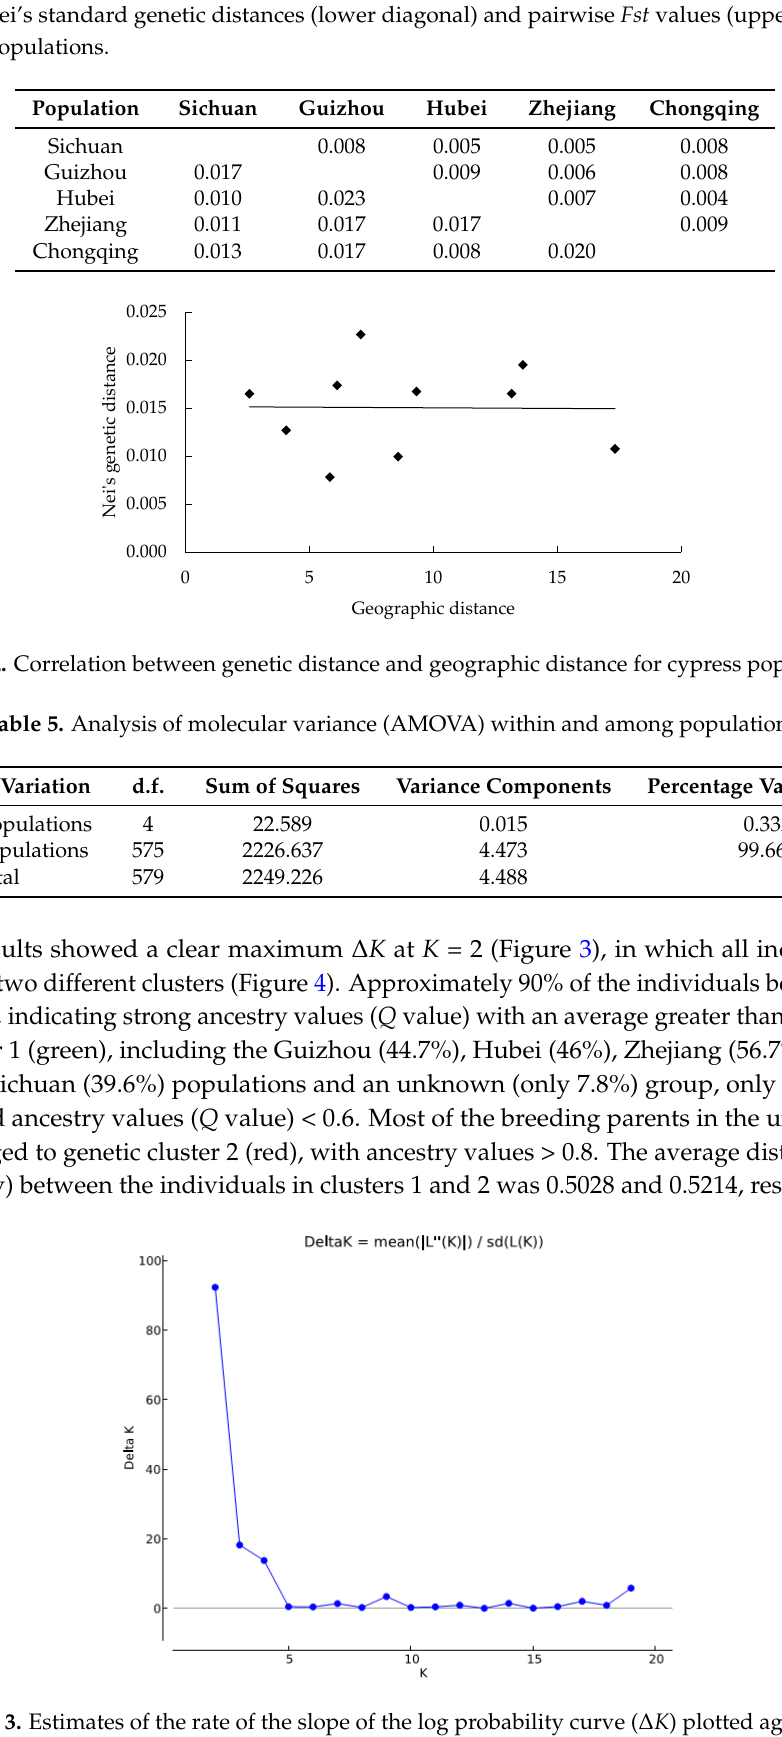
Figure 4. Assignment of 343 breeding parents to two populations using Structure version 2.0. 3.1.4. Construction of Genetic Core Collection Figure 5 shows SSRs with significant linkage equilibrium ( R 2 < 0.3; p < 0.01), and no SSRs showed linkage disequilibrium (LD). A core collection containing 30 genotypes retaining all 93 alleles identified from breeding parents was defined. The core collection contained six (11.3%) breeding parents from Hubei, seven (14.0%) breeding parents from Sichuan, seven (8.1%) breeding parents from Zhejiang, three (8.6%) breeding parents from Guizhou, three (4.5%) breeding parents from Chongqing, and four (7.5%) breeding parents from an unknown population. The observed and expected heterozygosity ( Ho and He ) values calculated for the core collection were close to those values for the overall genotypes (Table 6). Regarding the allele frequency, the chi-square test showed that the core collection had a similar allelic distribution for all 17 SSR markers ( p > 0.05). Moreover, the frequency of alleles between this core collection and the overall breeding parents was highly correlated: not only were the same alleles detected but these alleles were also represented at a nearly identical frequency ( r = 0.98, Figure 6). Table 6. SSR diversity within the core collection compared with the overall breeding parents. Population